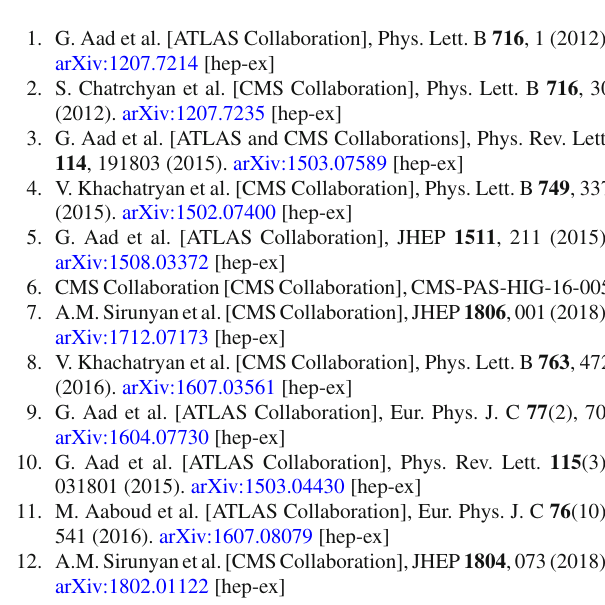
tion with respect to the variable H T 2 = p j 1 j 1 and j 2 the leading and subleading jets in the